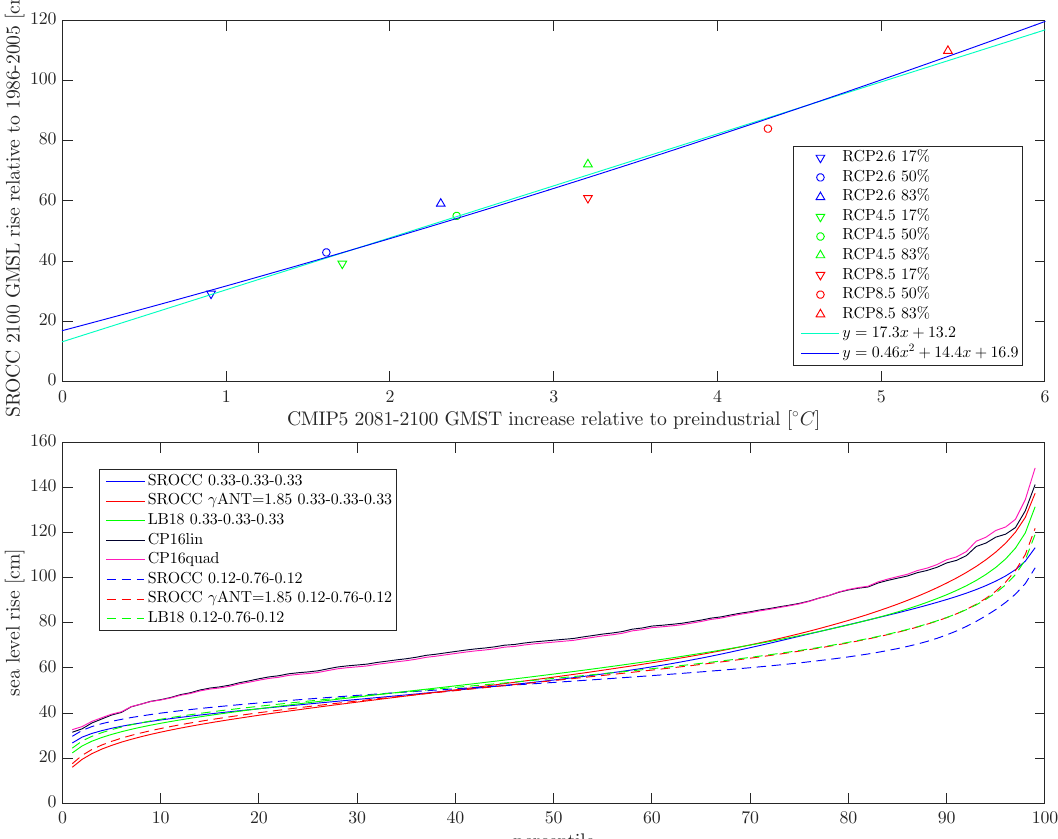
Figure 9. Sea level rise plotted against GMST increase from the SROCC report (top), and sea level rise projections based on the probabilistic baseline scenario (bottom). The SROCC γ ANT model is used here with γ = 1.85, which gives a close agreement with the SROCC median value and likely